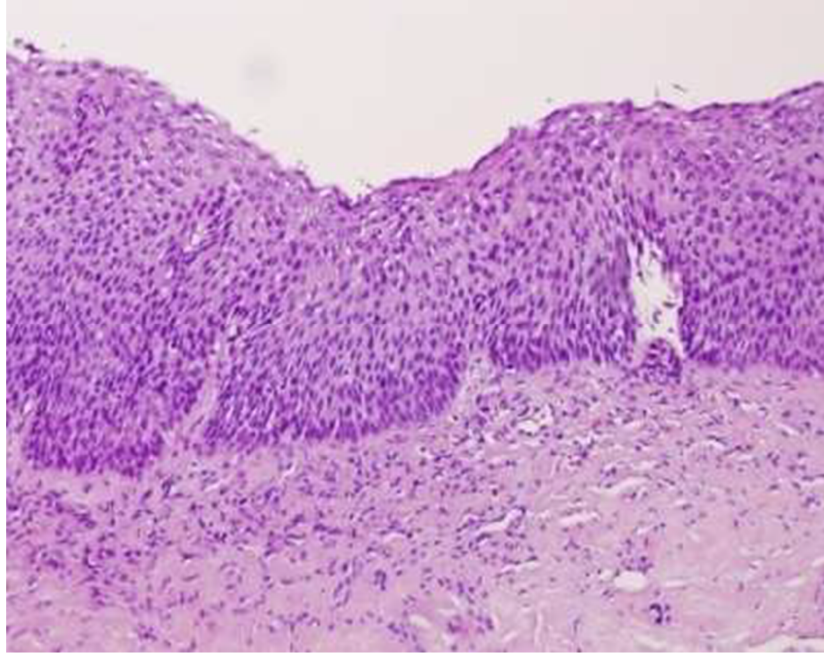
Figure 5. High-grade anal squamous intraepithelial neoplasia (AIN3+) 40×. Courtesy of Dr. Mauricio Iribarren, General Surgery Department, Álvaro Cunqueiro Hospital, Vigo.